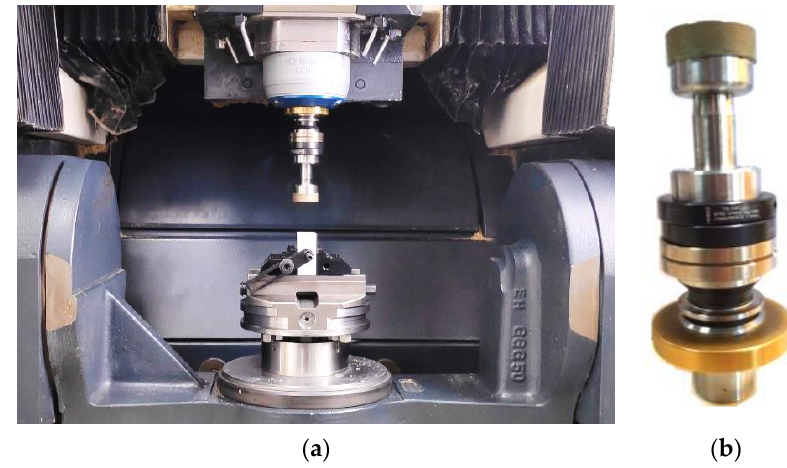
Figure 1. Devices used: ( a ) Experimental set-up; ( b ) Balanced tool-holder.